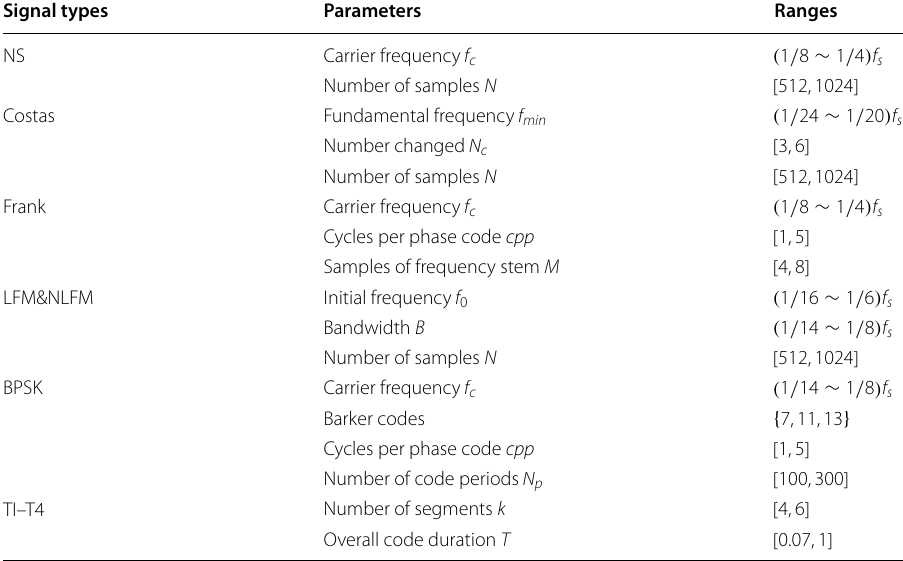
Table 1 Signal parameters and simulation conditions Signal